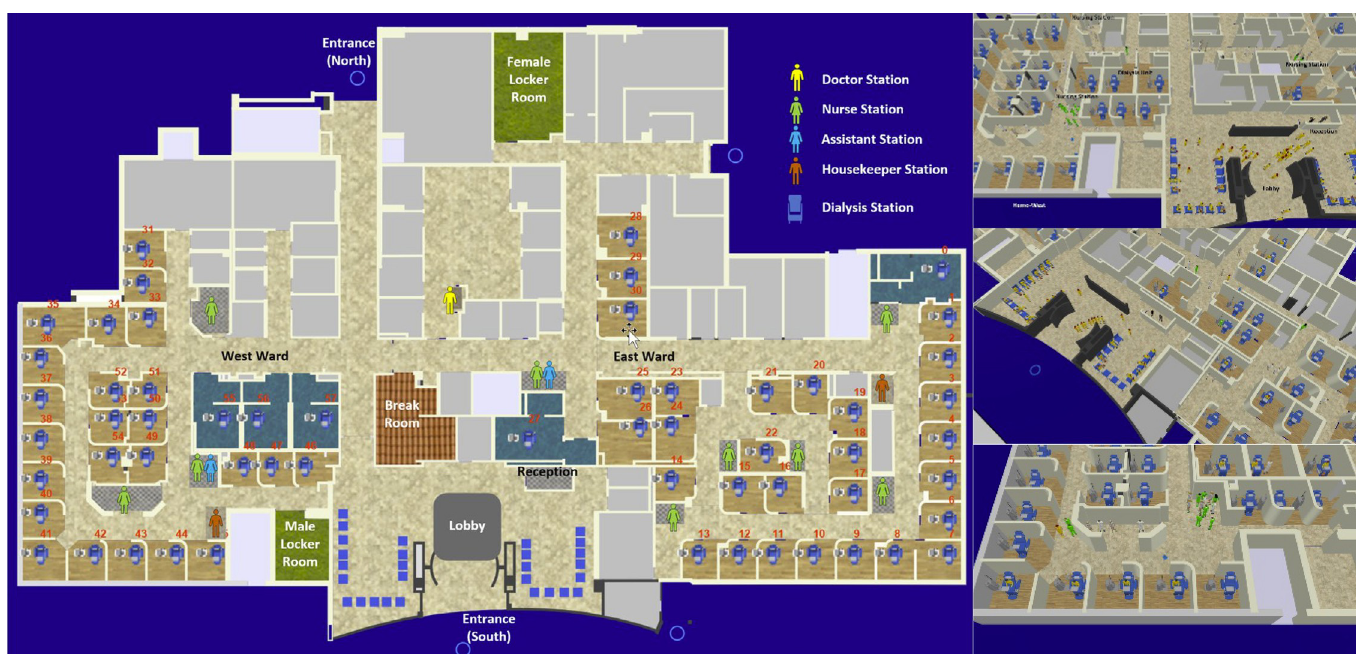
Fig 1. 2D and 3D models of Toronto General Hospital, hemodialysis departments developed for the simulations.